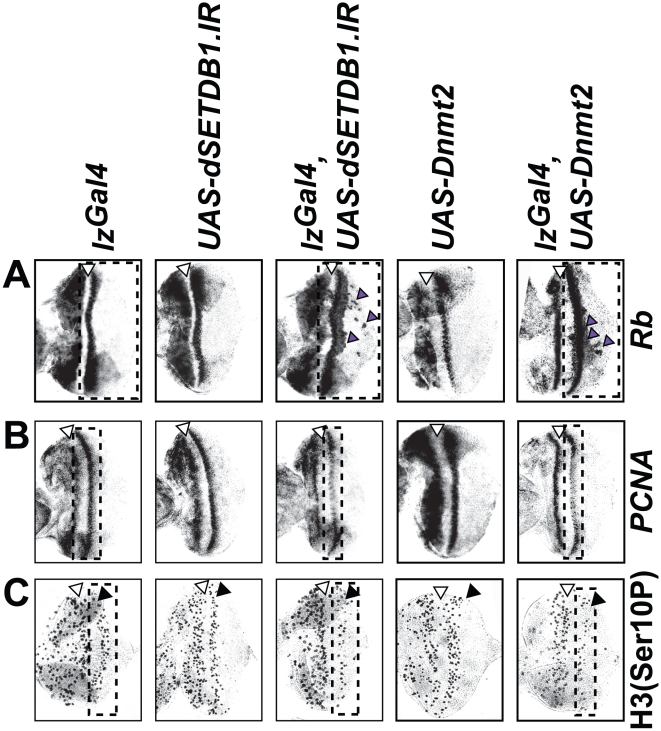
dSETDB1 represses Rb expression in the developing eye.(A, B) In situ hybridization assays detecting the transcription of (A) Rb and (B) proliferating-cell nuclear antigen (PCNA) in eye imaginal discs prepared from control 3rd-instar larvae containing the lzGal4 driver, the reporter UAS-dSETDB1.IR or UAS-Dnmt2, and lzGal4 with UAS-dSETDB1.IR (lzGal4;UAS-dSETDB1.IR) or lzGal4 with UAS-Dnmt2 (lzGal4;UAS-Dnmt2). (C) Immunostaining assays detecting the mitotic marker phosphorylated H3 (serine 10) in eye imaginal discs described in (A,B). The mitotic index is38+3 for lzGal4 eye discs, 37+4 for UAS-dSETDB1.IR discs, 36+2 for UAS-Dnmt2, 9+3 for lzGal4;UAS-dSETDB1.IR and 11+2 for lzGal4;UAS-Dnmt2 discs. (A-C) The white-filled arrowheads mark the position of the morphogenetic furrow (MF). (A) Blue arrowheads indicate areas of ectopic Rb transcription in the posterior region (rectangle) of eye imaginal discs lacking dSETDB1 or Dnmt2, as compared to controls (see area marked by rectangle in lzGal4 discs). (B) The rectangle marks the position of the posterior PCNA transcription domain. The transcription of the posterior PCNA domain (rectangle) is reduced in dSETDB1 or Dnmt2 deficient eye imaginal discs as compared to controls. (C) The dark arrowhead marks the position of mitotic cells in the second mitotic wave posterior to the morphogenetic furrow. Note that the number of mitotic cells in regions posterior to the morphogenetic furrow (rectangle) is significantly reduced in eye discs lacking dSETDB1 or Dnmt2 through RNAi.